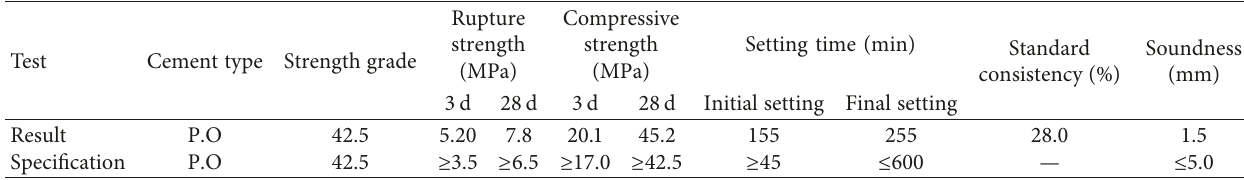
Table 1: Properties of Portland cement.